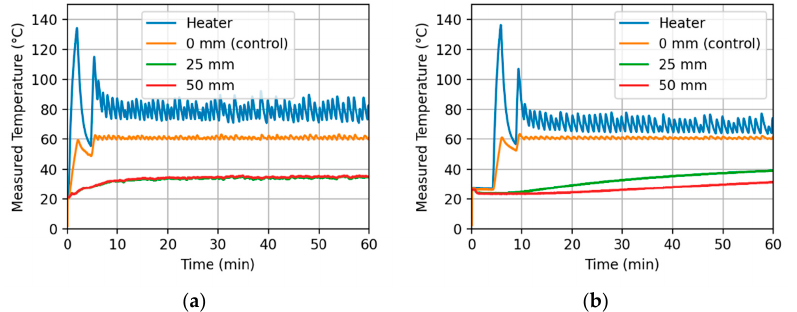
Figure 19. Temperature gradient measurements with the inside surface temperature used for con- trol. ( a ) Chamber empty and open to the air, average heater temperature 79 °C at steady state. Note that the 25 and 50 mm curves lie on top of each other, since both are measuring air tempera- ture inside the chamber; ( b ) chamber loosely packed with rPET, average heater temperature 68 °C at steady state.